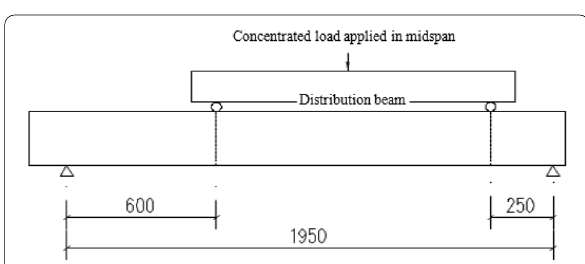
Fig. 5 Loading schematic diagram of beams under test.